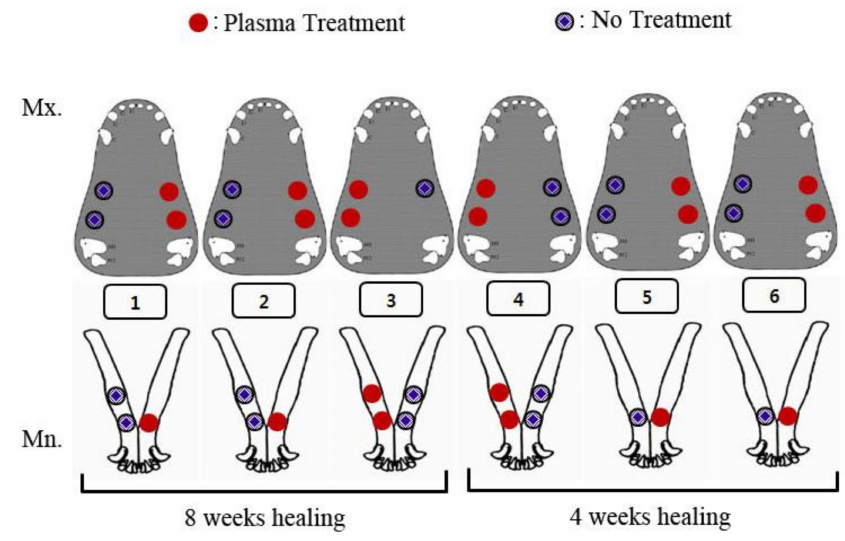
Figure 3. Schematic diagram of experimental